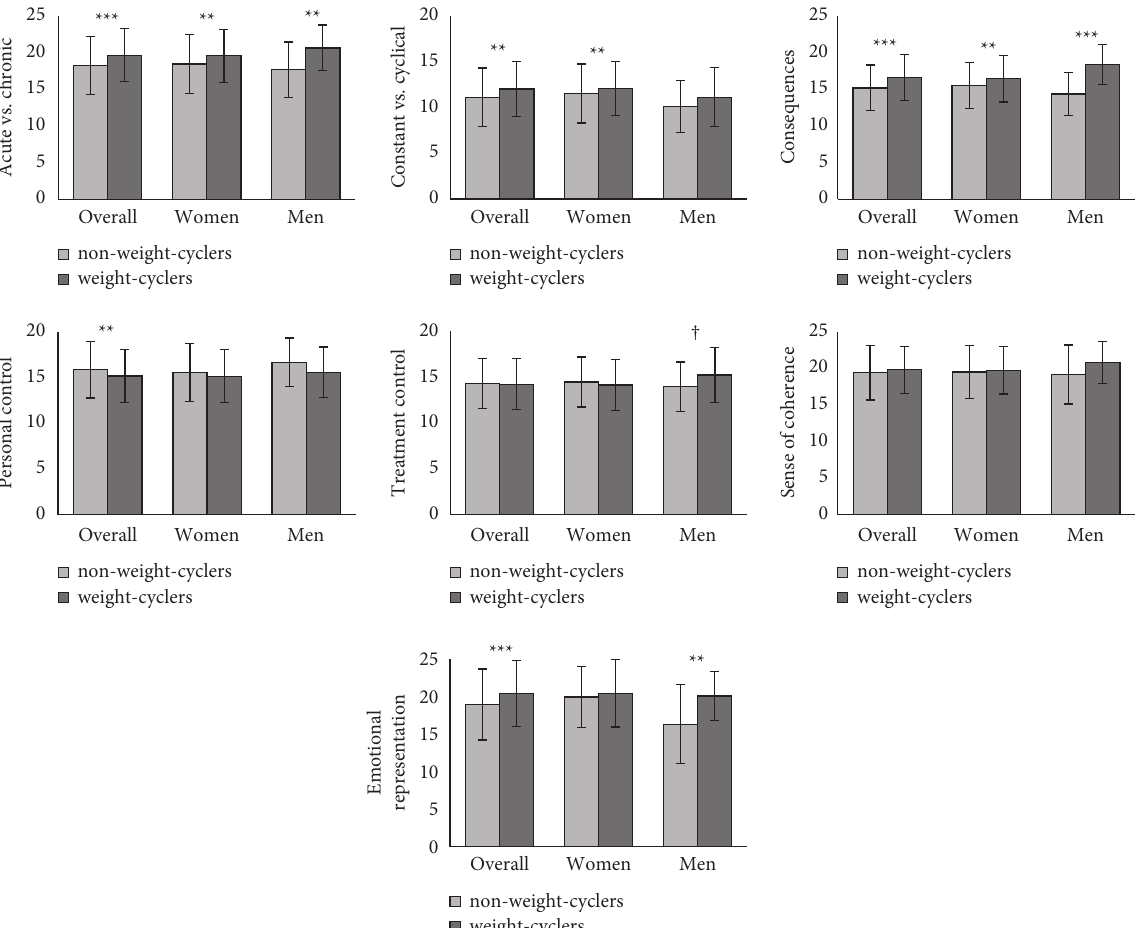
Figure 1: Expression of the SIR in weight- and non-weight-cyclers in the overall sample as well as female and male subsamples (for numerical values see Table 3). The error bars represent the standard deviation of measurements of the SIR for weight- and non-weight- cyclers. Note. p value (one-sided): † marginally significant, ∗ p < 0 . 05, ∗∗ p < 0 . 01, ∗∗∗ p < 0 . 001; weight-cyclers: 10 or more diet attempts (overall N � 212, women n � 196, men n � 16), non-weight-cyclers: fewer than 10 or no diet attempts (overall N � 221, women n � 160, men n �